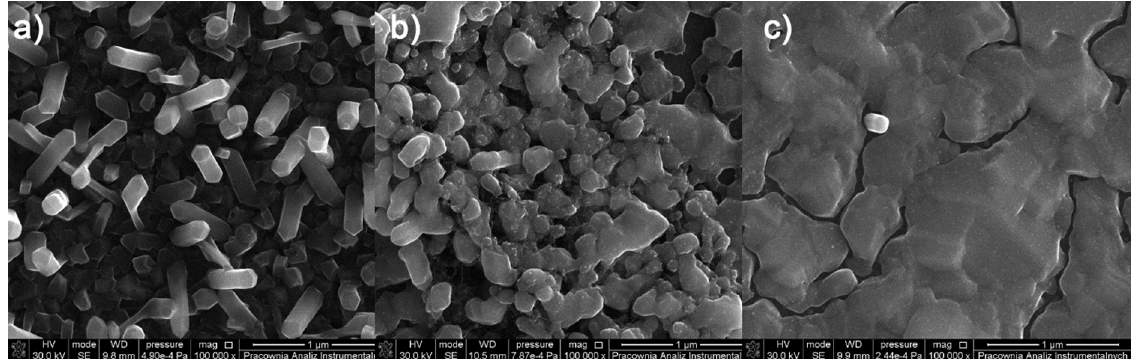
Figure 8. SEM pictures of deposits for the precursor [Cu 2 (EtNH 2 ) 2 (µ-O 2 CC 2 F 5 ) 4 ] ( 2 ), Mag = 150,000×, (( a – c )—orderly with the increasing transport way), T V = 473 K, T D = 713 K, Si(111), Ar.